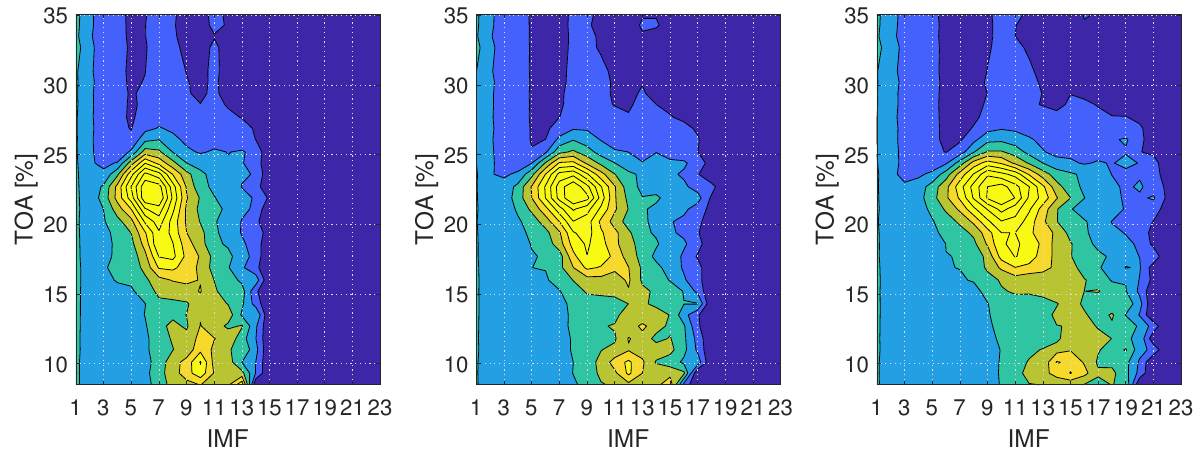
Figure 4. Mean energy E of dynamic pressure signal from p s − imp 1 sensor before impeller for signal portions of length N = 10,000; ( left ) 8 sifting iterations, ( middle ) 16 sifting iterations, ( right ) 32 sifting